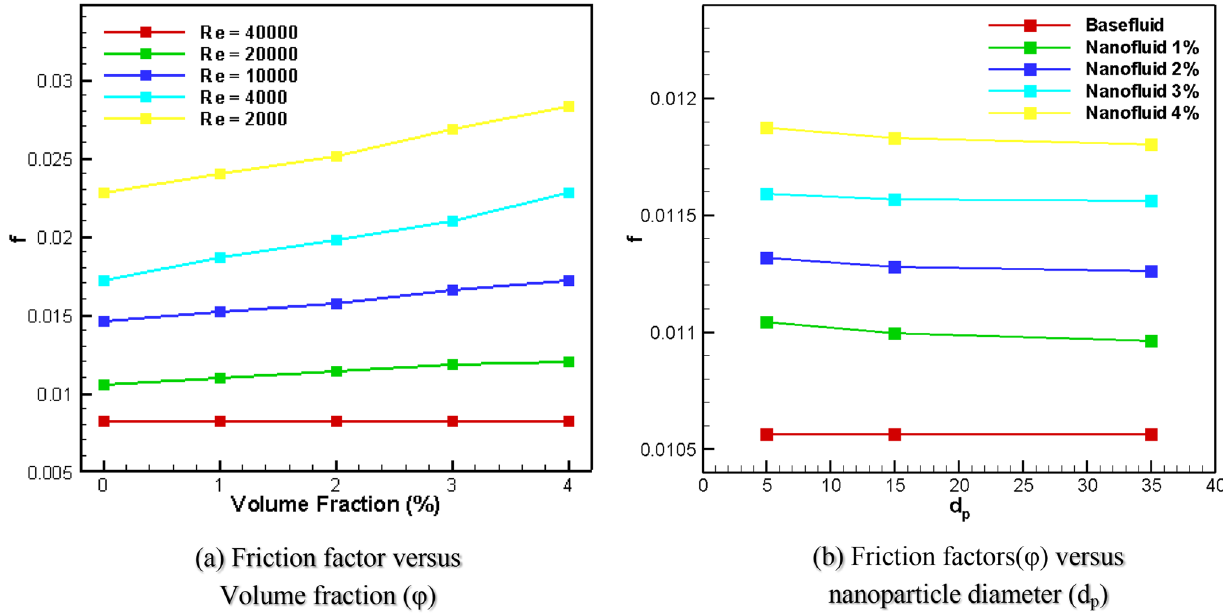
Fig. 9 Friction Analysis. a the Volume Fraction versus f for comparison between the all adopted Reynolds. b the d between the base fluid and different amounts of